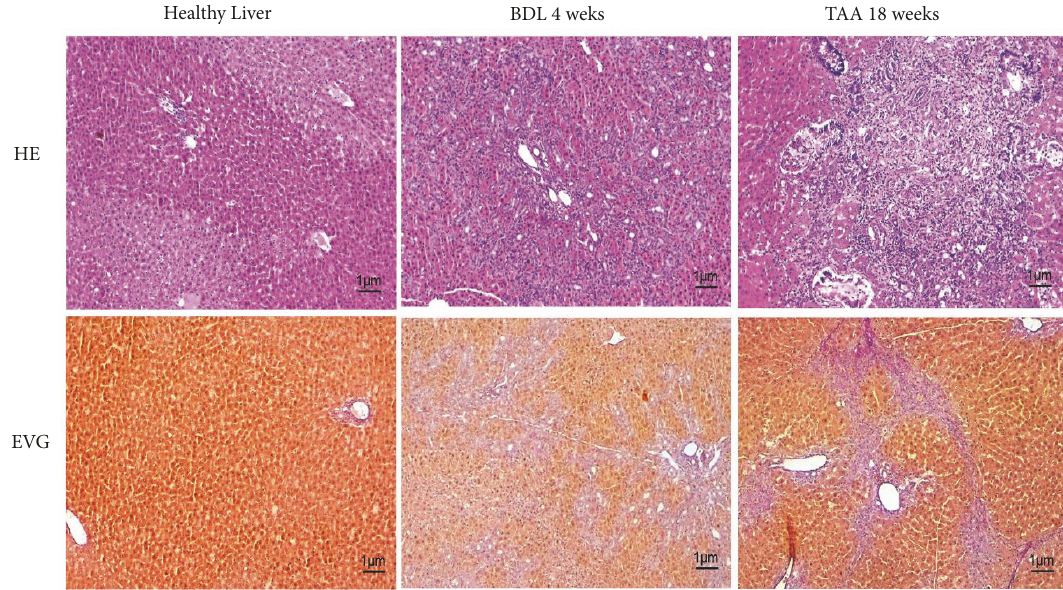
Figure 2: Histological evaluation of healthy, fibrotic, and cirrhotic livers after warm ischemia . After the induction of liver fibrosis in male SD rats using bile duct ligation (BDL) and the induction of liver cirrhosis using thioacetamide (TAA) administered via drinking water, healthy (a/b), fibrotic (c/d), and cirrhotic (e/f) livers were perfused (100x magnification). A stabilization period of 30 min was followed by 90 min of storage at 37 ∘ C and 90 min of reperfusion. For the IPostC intervention groups, 8x20 sec and 4x60 sec cycles were performed after ischemia (control and intervention groups, each with n=8). After the experiments, liver samples were fixed in 4% formalin and histologically evaluated (Table